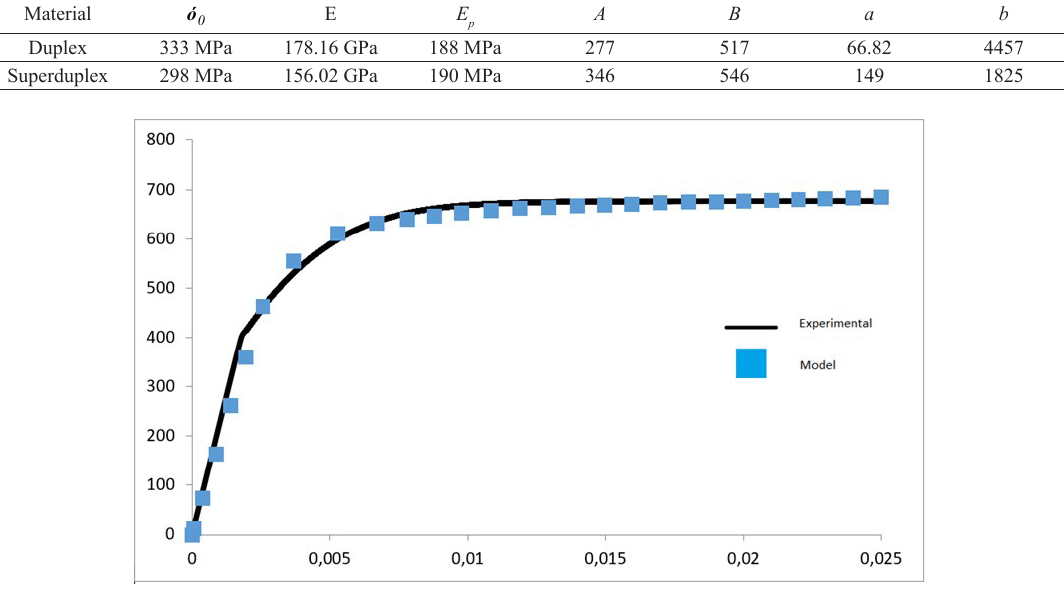
Figure 6. Comparative stress curve (MPa) - strain (mm / mm) - . UNS S3180F51 duplex stainless steel.